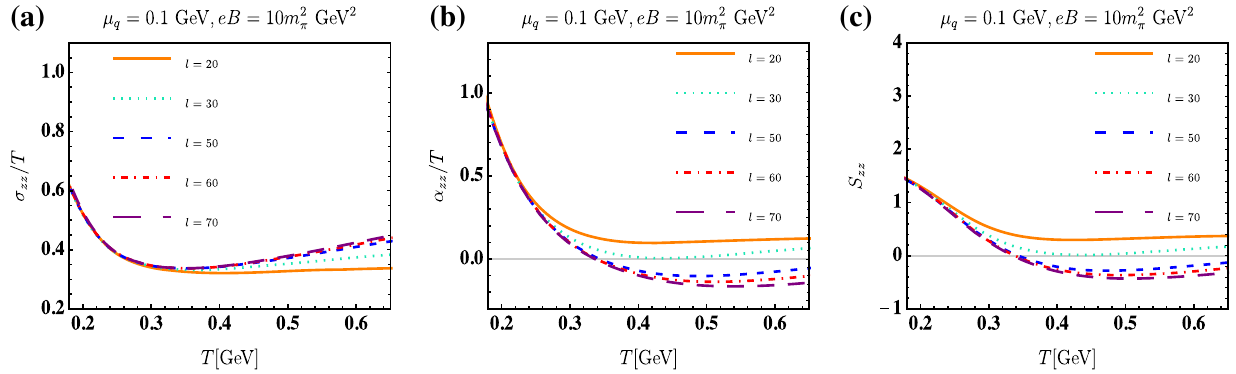
Fig. 7 The temperature dependences of the scaled longitudinal elec- trical conductivity (σ zz / T ) ( a ), the scaled longitudinal thermoelectric conductivity (α zz / T ) ( b ) and the longitudinal Seebeck coefficient ( S zz )